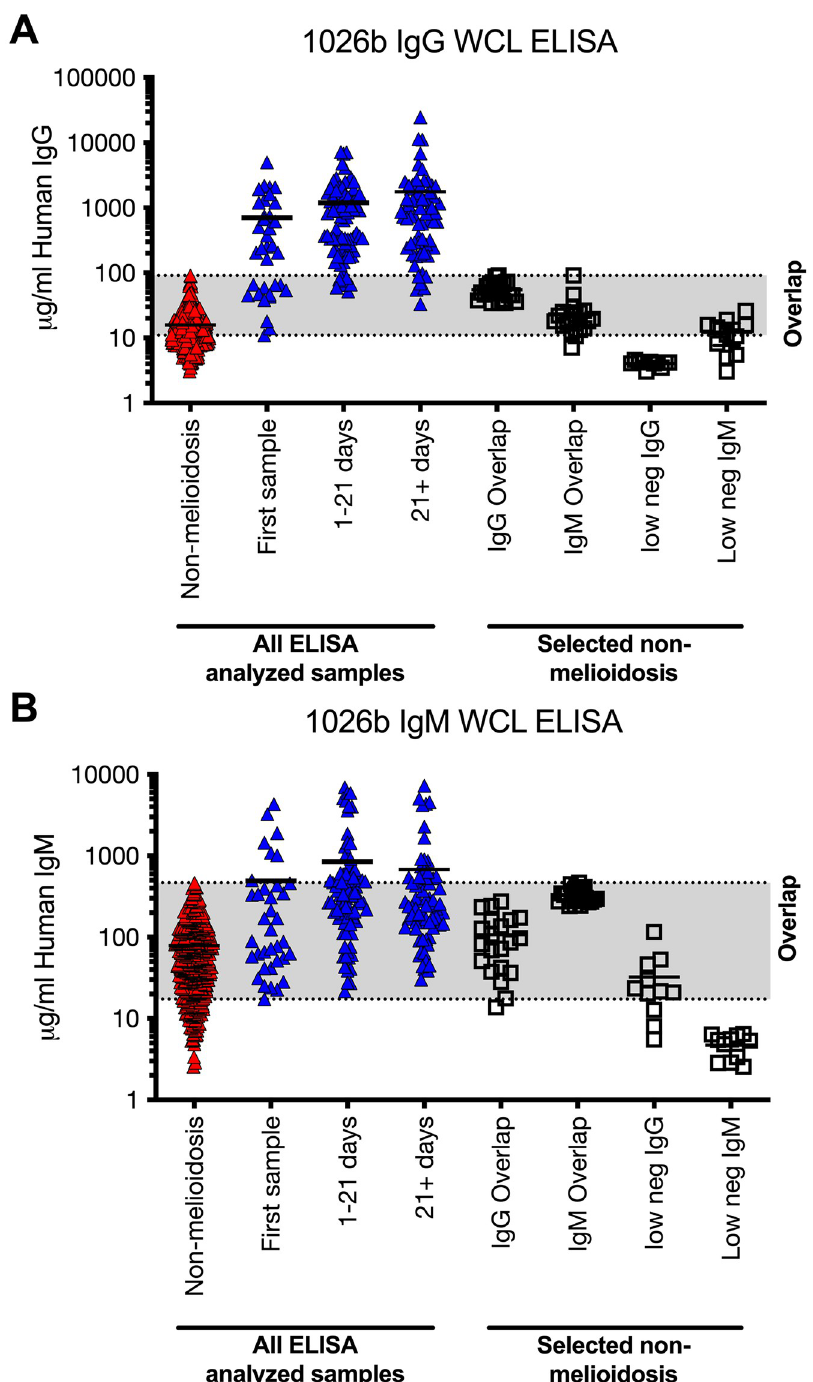
Fig 1. Serum reactivity of melioidosis-confirmed patients and non-melioidosis individuals to B . pseudomallei whole cell lysate ELISA. Serum IgG (A) or IgM (B) reactivity as determined by B . pseudomallei 1026b whole cell lysate ELISA. Triangles represent ELISA analyzed serum (n = 585) from 436 individuals (36 melioidosis and 400 non- melioidosis individuals) and squares represent selected serum samples to evaluate potential diagnostic antigens. The overlap between the negative and the positive samples are shown in